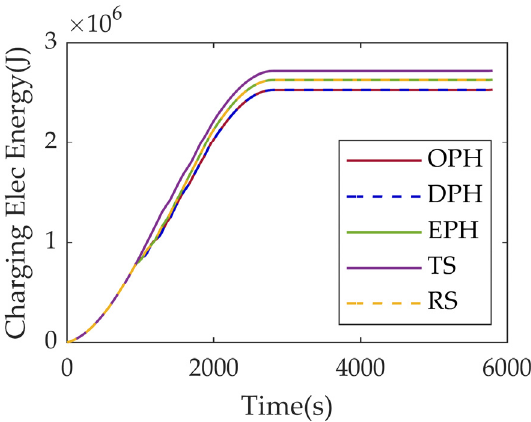
Figure 18. Charging electrical power chart of a single condition in the third group.